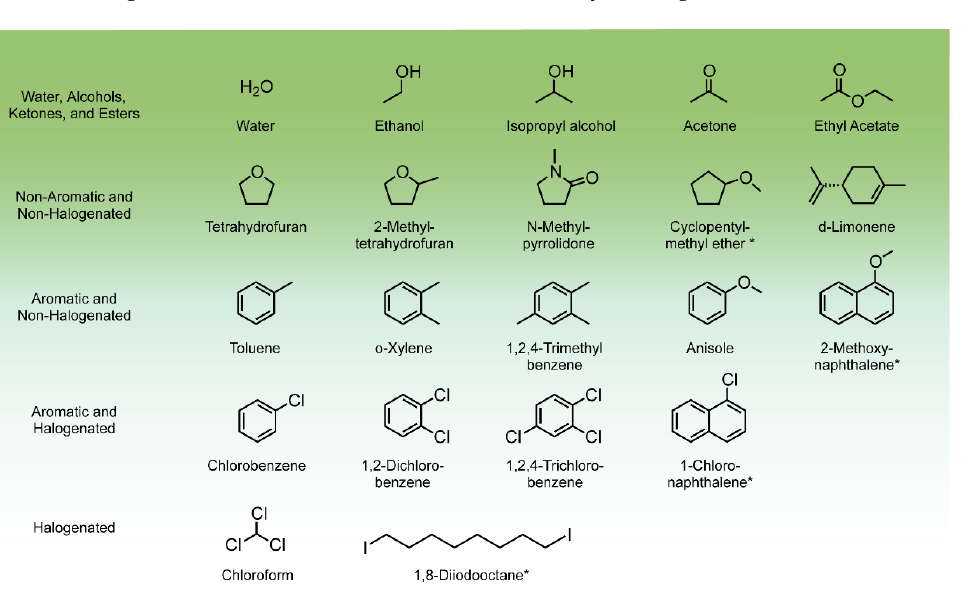
Figure 1. Representative examples of solvents used for BHJ solar cells organized in five general categories. Solvent hazard increases with the fading of green. Reviews about the toxicity and the environmental impact of the solvents have been recently published [16,20]. The mark ∗ indicates solvent additives.